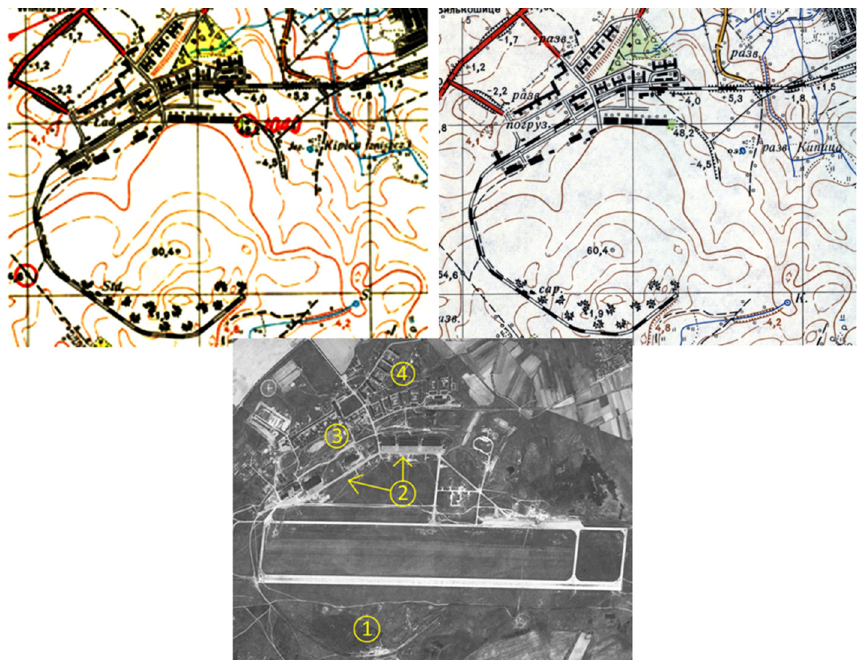
Fig. 5. The method of camouflaging the Chojna airfield on the Polish and Soviet maps from 1956